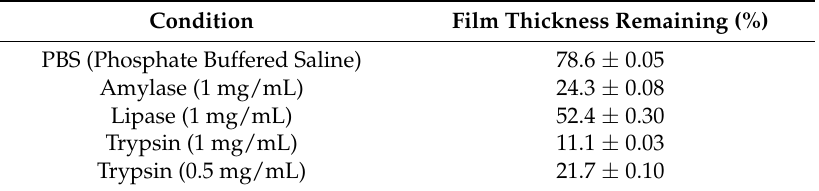
Figure 1. Resulting interdigitated finger electrode (IDE) sensors, with ( Left ) and without ( Right ) gelatin films, ( a ) pre-exposure to solutions, and post-exposure to ( b ) buffer; ( c ) trypsin; or ( d ) all three enzymes in buffer. Scale bar = 1 mm. Table 1. Ratio of spin-coated film remaining after various enzyme conditions, analyzed with a contact profiler ( n = 2).